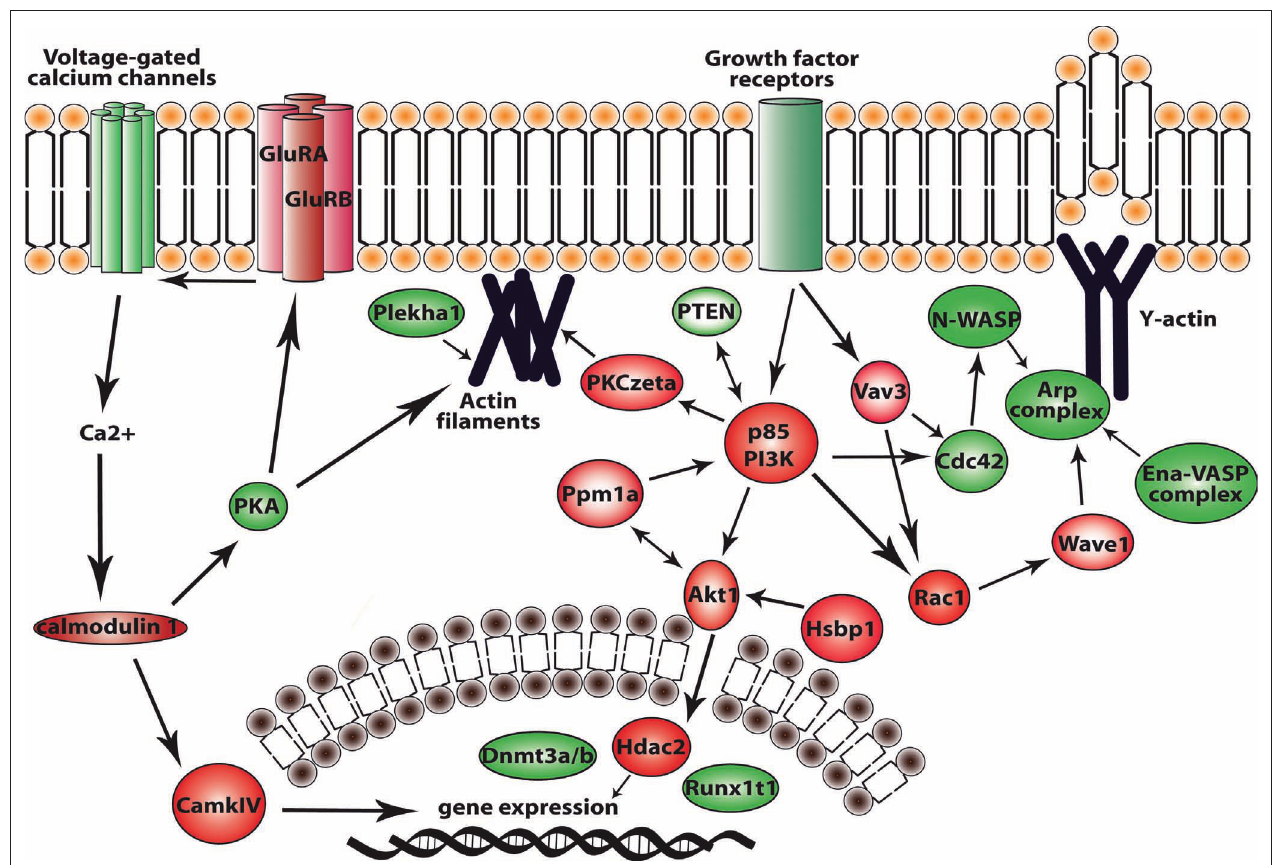
FIGURE 9 | Major signaling pathways in migrating neuroblasts resulting from our study. In red are proteins that we showed in vivo to be important for migrating neuroblasts. In green are proteins that might be involved in neuroblast migration according to our microarray data and bioinformatics